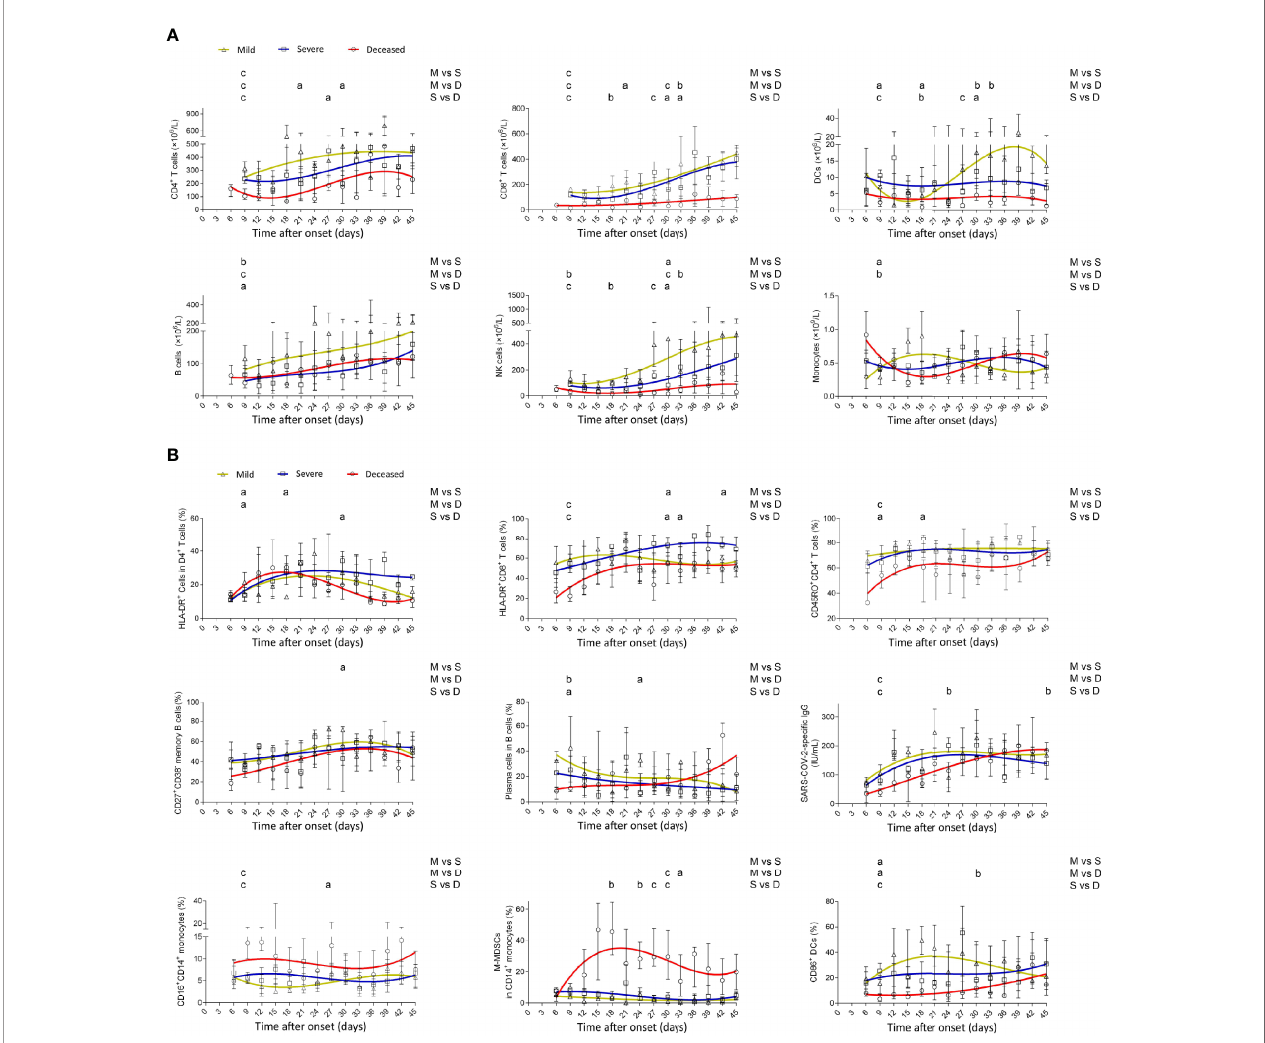
FIGURE 2 | Dynamic analysis of the number, phenotype, and function of immune cells in patients with different outcomes. (A) The absolute numbers of CD4 + T cells, CD8 + T cells, B cells, NK cells, lymphoid-derived DCs, and monocytes and (B) the percentages of HLA-DR + CD4 + T cells, HLA-DR + CD8 + T cells, CD45RO + CD4 + T cells, CD27 + CD38 − memory B cells within CD19 + B cells, CD27 + CD38 high plasma cells within CD19 + B cells, SARS-CoV-2-speci fi c IgG, CD16 + CD14 + monocytes, HLA- DR − CD14 + M-MDSCs within monocytes, and CD86 + lymphoid-derived DCs in the peripheral blood of mild (yellow line), severe (blue line), and deceased (red line) COVID- 19 patients were analyzed at different time points (every 3 days from day 3 to day 45 after onset of illness). Data in each time point are expressed as median with interquartile range. The smoothing cubic splines were fi tted to the values of different parameters to summarize the overall trend. Lymphoid-derived DCs, dendritic cells; SARS-CoV-2, severe acute respiratory syndrome coronavirus 2; M-MDSCs, monocytic-myeloid-derived suppressor cells. a p < 0.05; b p < 0.01; c p < 0.001. M, mild; S, severe; D,